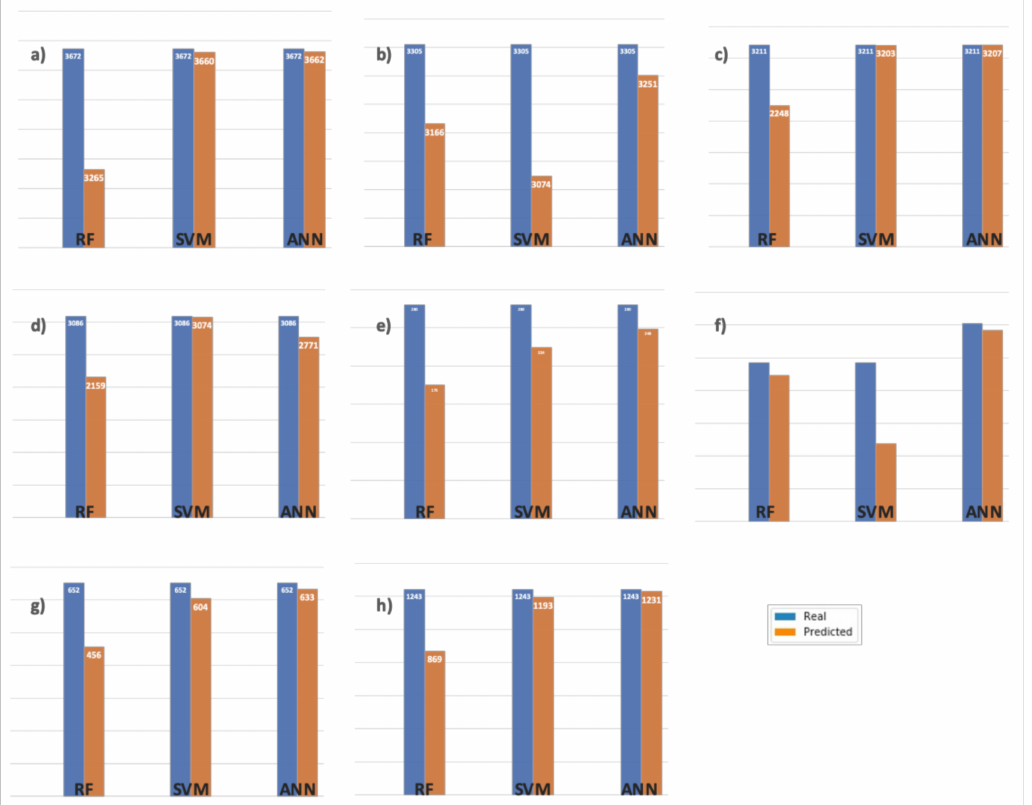
Figure 6. Comparison of real vs. predicted values for each dataset, considering the labels “low” and “high” for each dataset and each of the algorithms used (RF, SVM, and ANN). Data distribution: ( a ) “low” with dataset A1, ( b ) “low” with dataset A2, ( c ) “low” with dataset B1, ( d ) “low” with dataset B2, ( e ) “high” with dataset A1, ( f ) “high” with dataset A2, ( g ) “high” with dataset B1, and ( h ) “high” with dataset